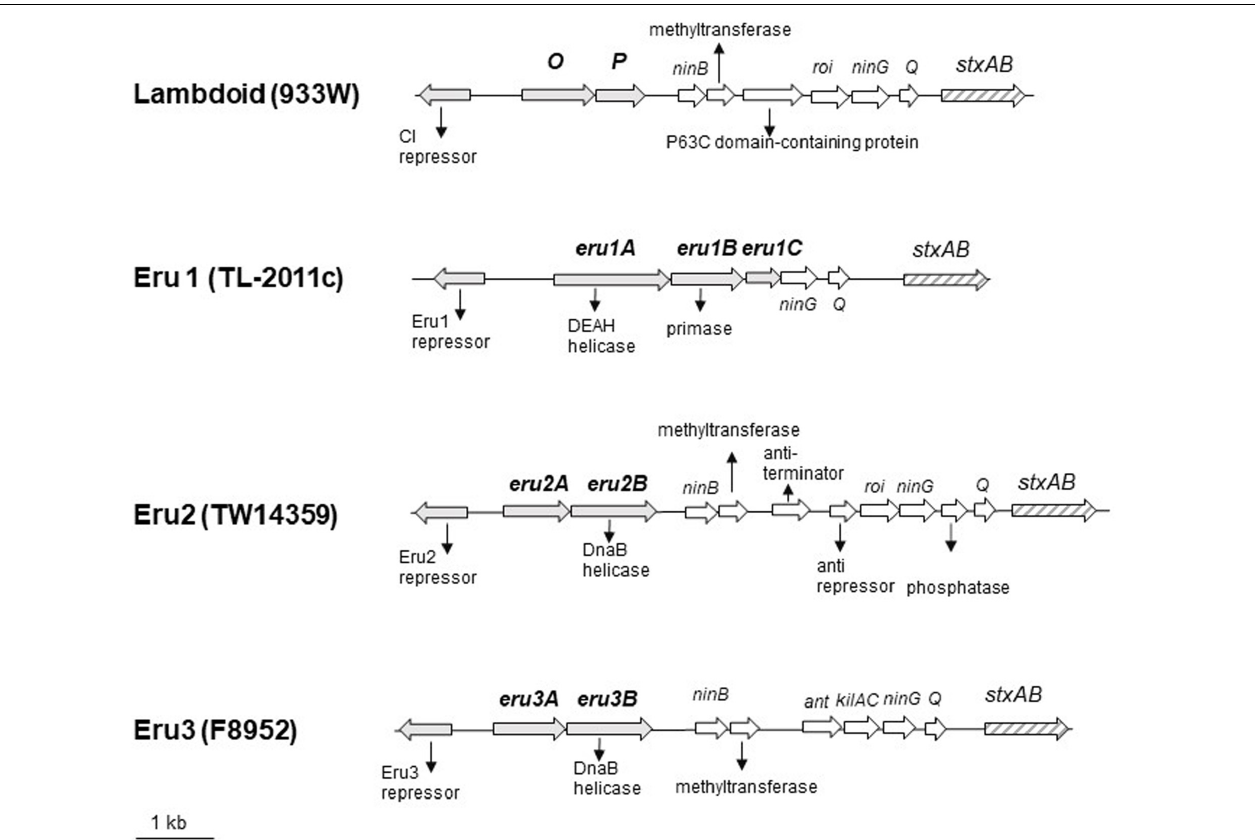
FIGURE 2 | Physical maps of the Stx2 phages carrying the lambdoid (933W, NC_000924; 12075–22702), the Eru1 (TL-2011c, NC_019442; 17619–25677), the Eru2 (EHEC O157:H7 TW14359, NC_013008; 2695183–2707440), and the Eru3 replication region (STEC O157:H7 F8952, CP038349; 3391574–3402867). eru genes are indicated by gray arrows, and stx genes are indicated by striped